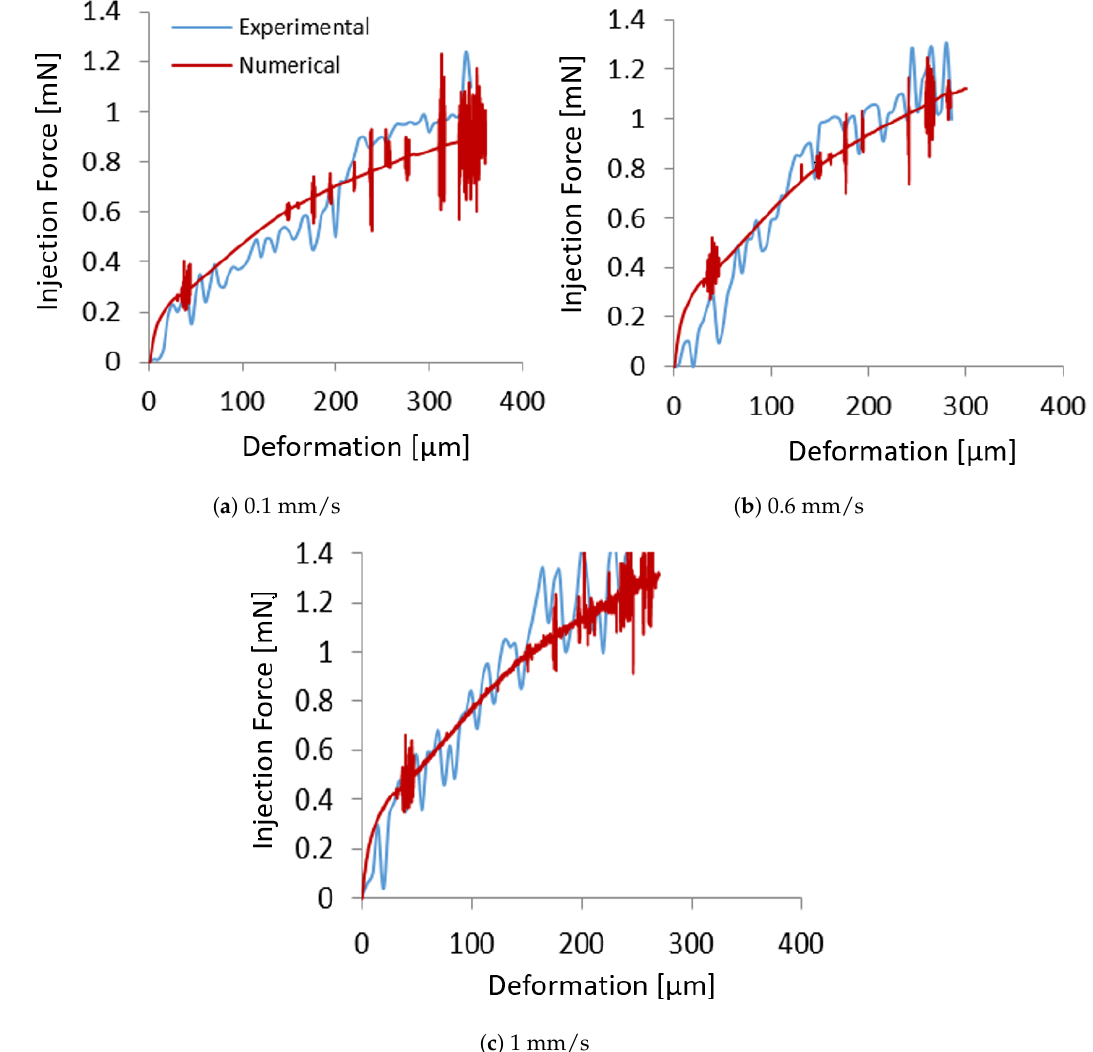
Figure 12. Comparison between experimental and numerical results in terms indentation force vs deformation for three various speeds: ( a ) 0.1 mm/s, ( b ) 0.6 mm/s, and ( c ) 1